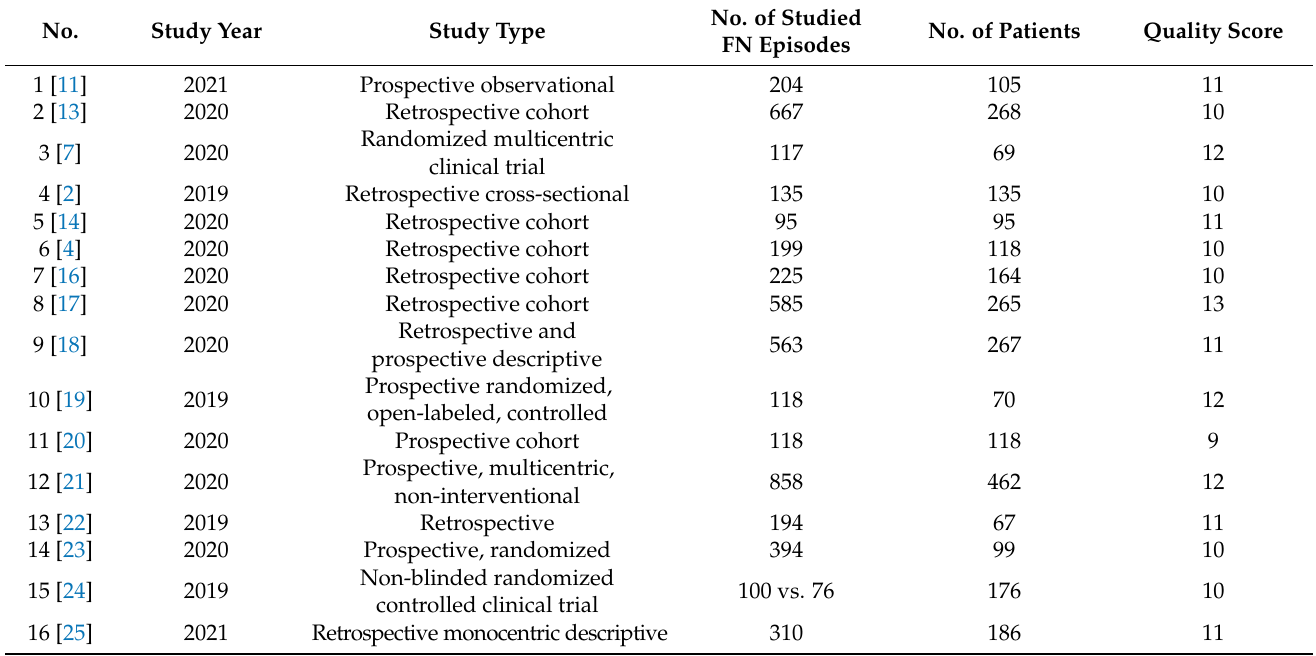
Table 1. Studies included in the